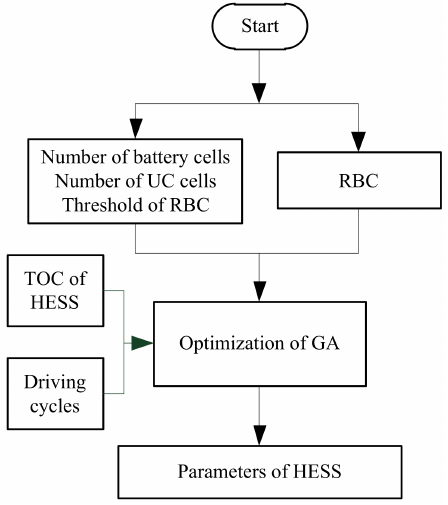
Figure 3. Diagram of parameters optimization.